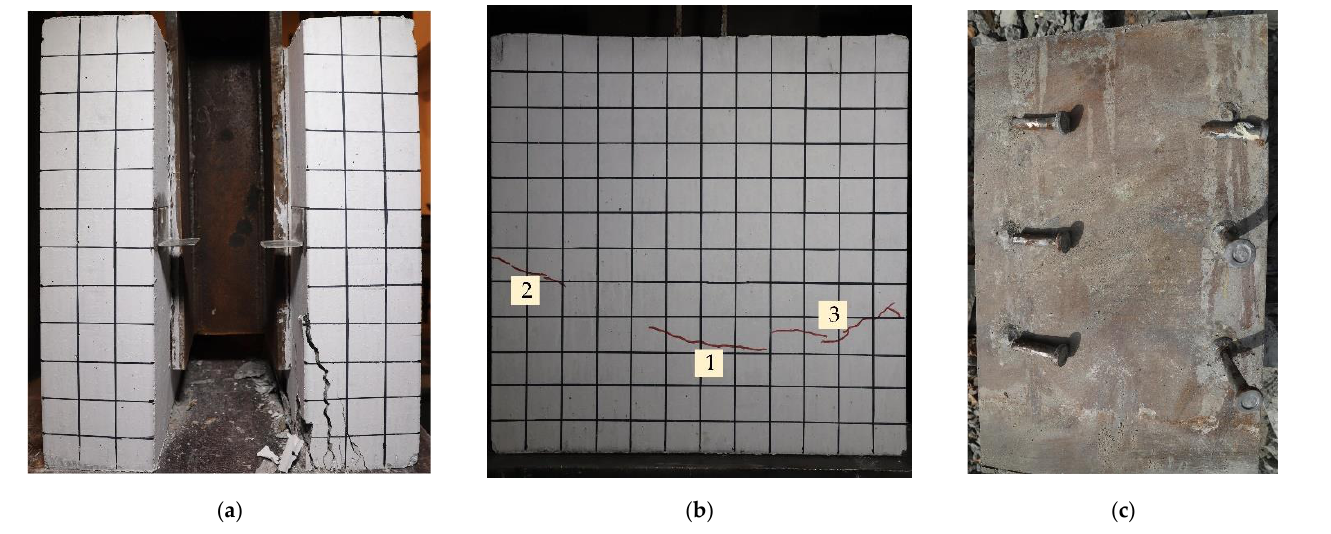
Figure 5. Failure modes of welded stud shear connector: ( a ) front of concrete slab; ( b ) side of concrete slab; ( c ) perforated steel plate.